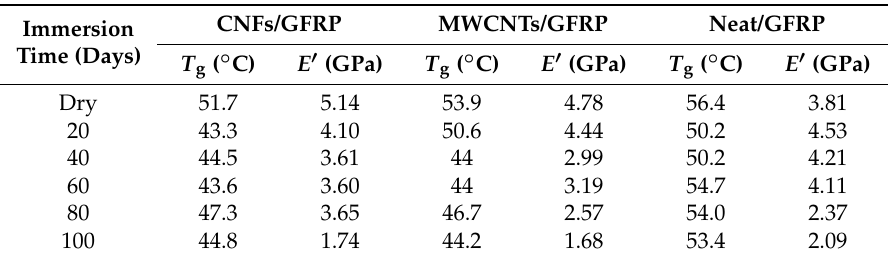
Table 1. Storage modulus ( E (cid:48) ) and glass transition temperature ( T g ) of Neat/GFRP, CNFs/GFRP, and MWCNTs/GFRP coupons immersed at temperature 22 ◦ C.